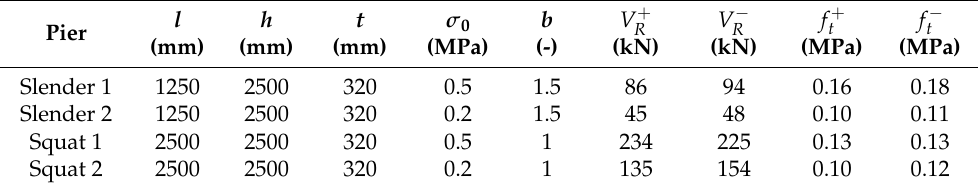
Table 4. Determination of the tensile strength from cyclic shear-compression tests on